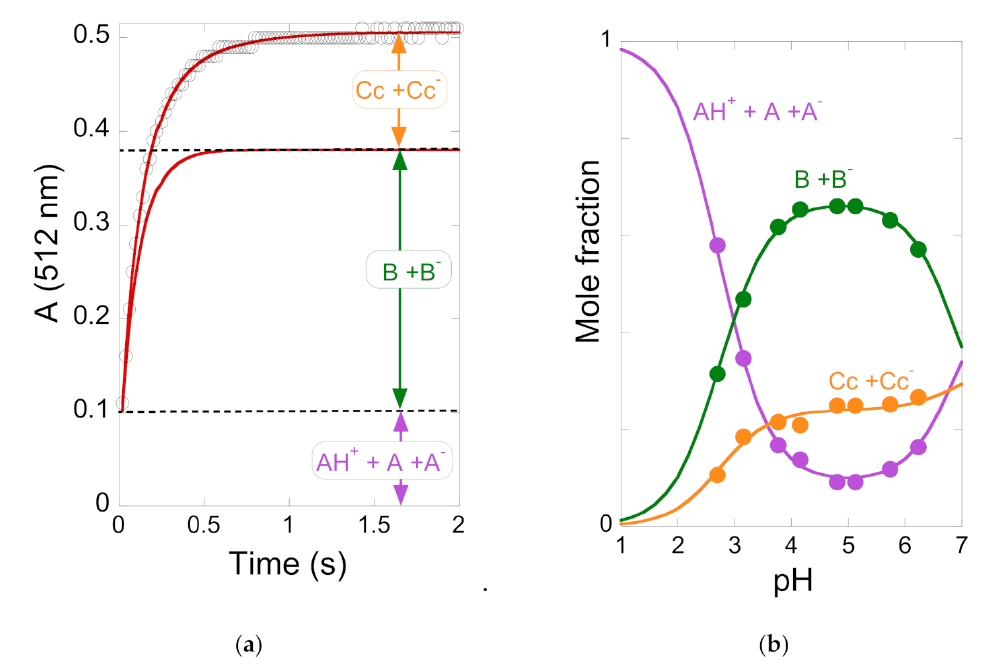
Figure 2. ( a ) Trace of a reverse pH jump of a pseudo-equilibrated solution of kuromanin at pH = 5.1 followed at 512 nm by stopped flow showing the three observed amplitudes; ( b ) mole fraction distribution at the pseudo-equilibrium, obtained after reverse pH jumps as in ( a ) for different pH values.